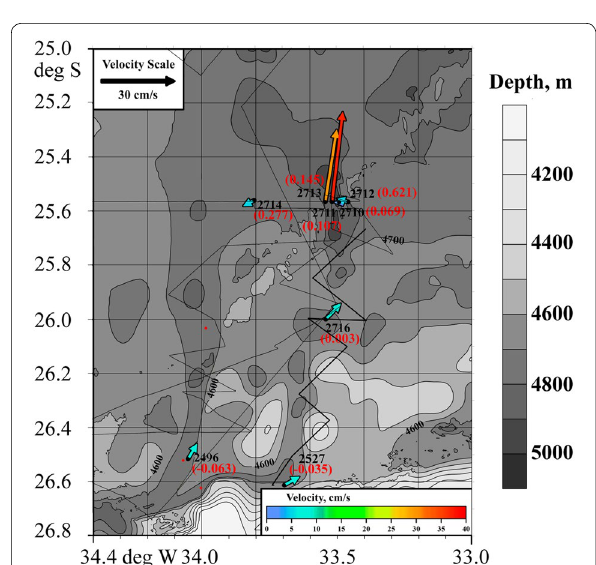
Fig. 6 Locations of stations in two deep channels north of the Vema Channel. Vectors of the LADCP velocities averaged over the 50-m bottom layer, and potential temperatures measured at the bottom (numbers in brackets) are shown. Thin lines show the lines of echo-sounder